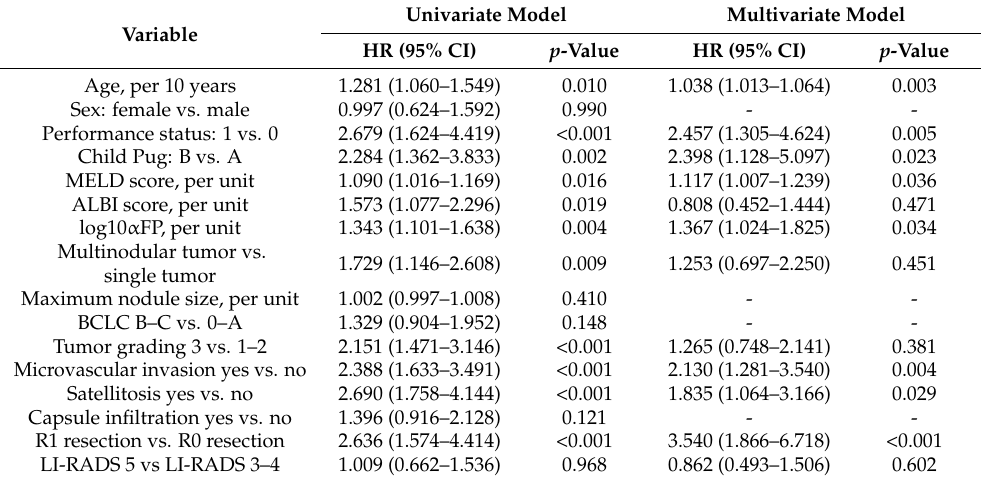
Table 4. Uni- and multivariate association of risk factors with overall survival by Cox